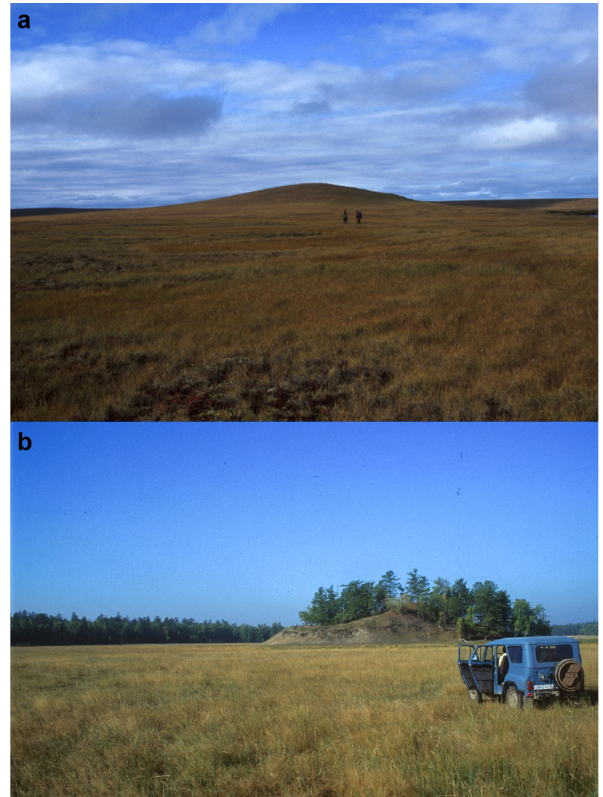
Fig. 1. Ca. 28m high closed-system pingo in a drained thermokarst lake basins in the tundra of the Bykovsky Peninsula, North Siberia (top) and ca. 7m high partially collapsed closed-system pingo in a dried-up thermokarst lake basin the taiga of central Yakutia (bot-